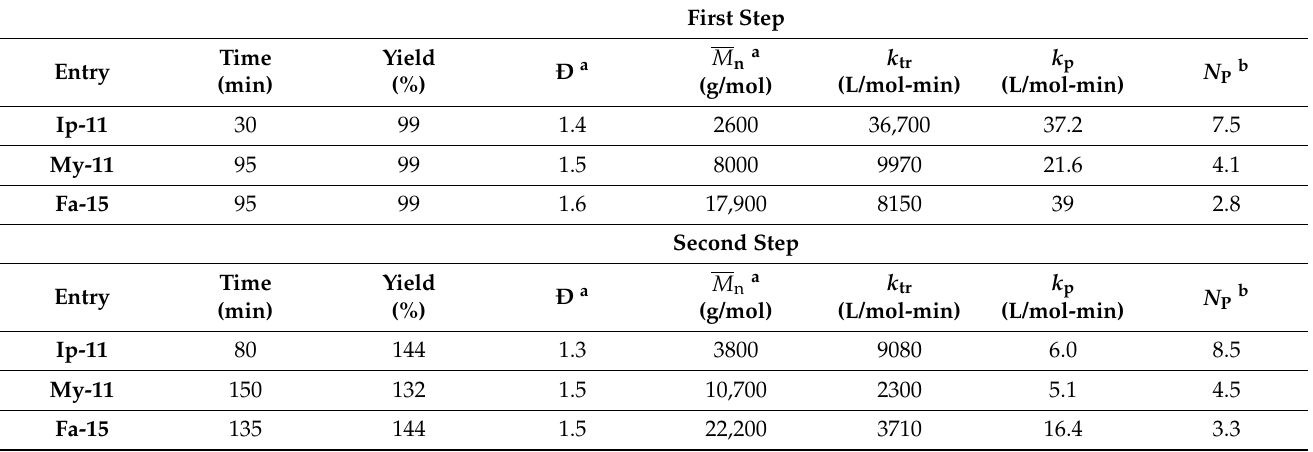
Table 6. Validation of CCTP regime through living polymerizations. First